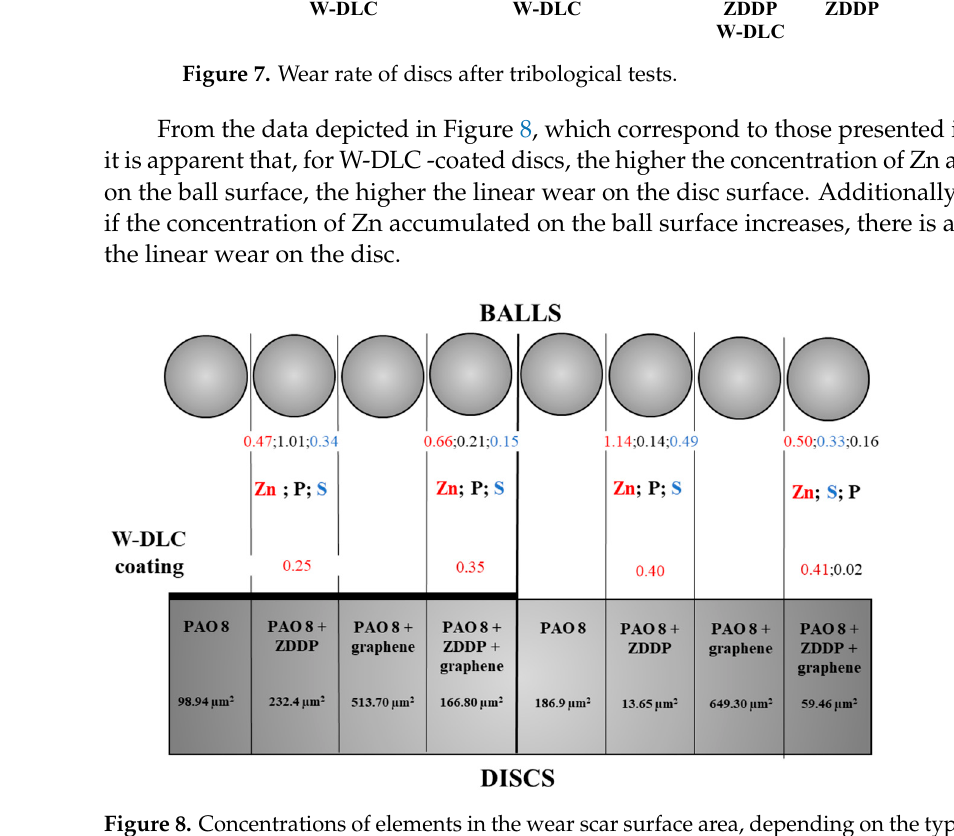
Figure 8. Concentrations of elements in the wear scar surface area, depending on the type of lubricant and the type of disc used.